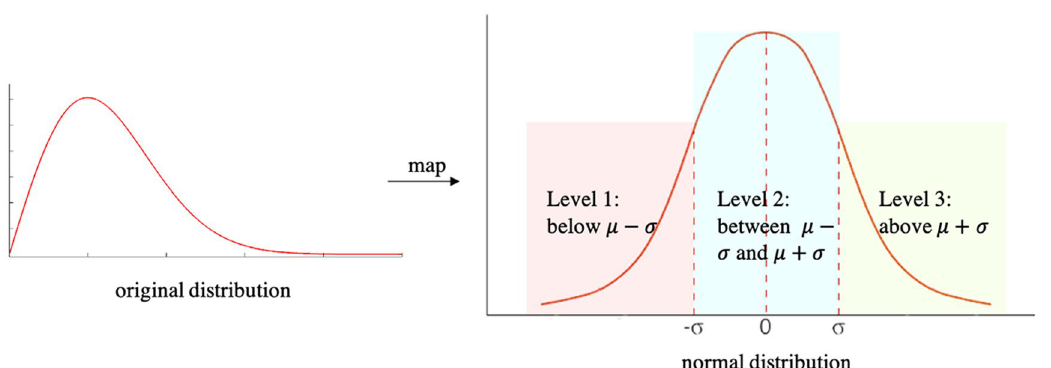
Figure 4. Distribution mapping for the deep attribute learning model. The original distribution of a morphological feature is mapped to a normal distribution. The deep attribute learning model predicts if a morphological feature value is below µ − σ , between µ − σ and + σ, or above µ + σ , where µ and σ refer to the mean and standard deviation of the original morphological feature value distribution.